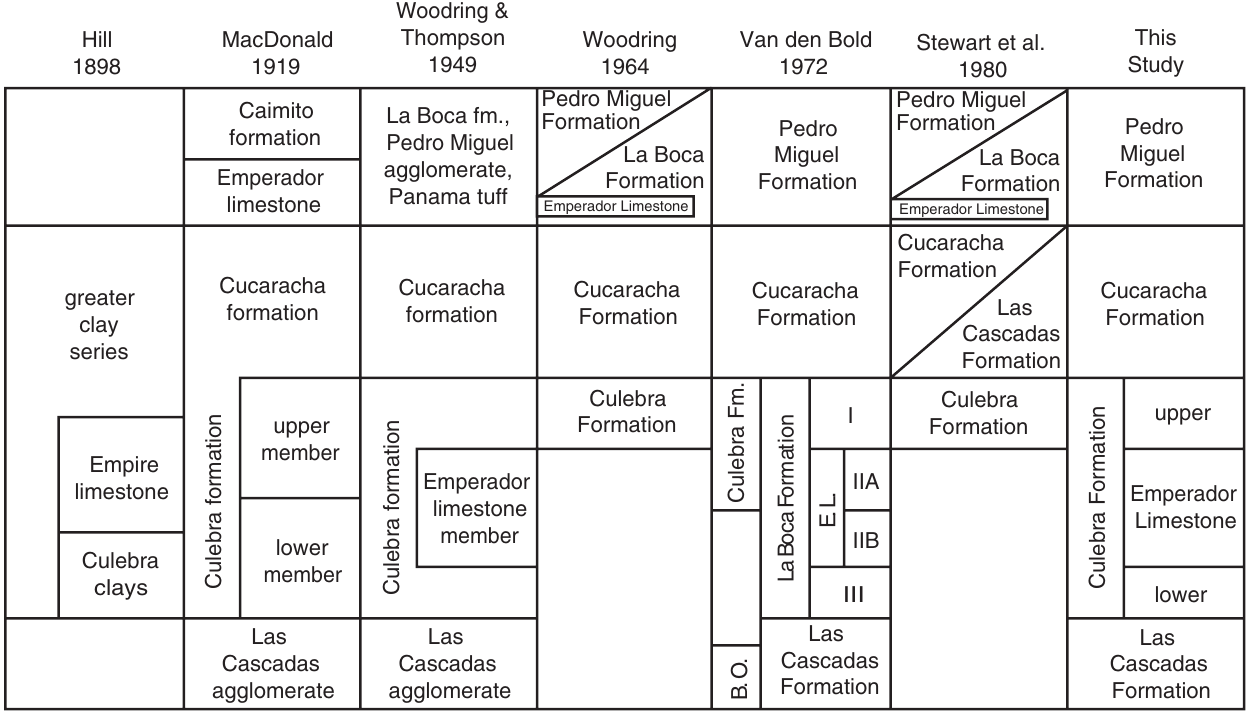
Figure 4. Summary of stratigraphic nomenclature for the formations exposed along the Gaillard Cut portion of the Panama Canal. B.O.=Bas Obispo Formation. E.L.=Emperador Limestone.